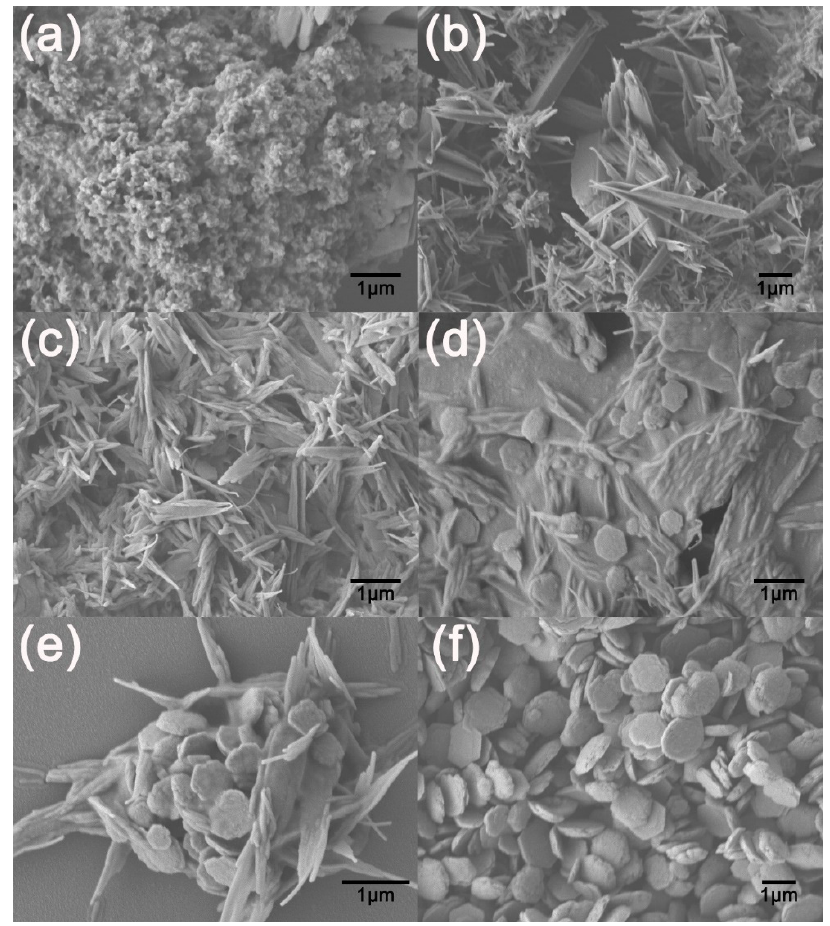
Figure 3. SEM images of products obtained in OS route at different times: ( a ) 0 min; ( b ) 10 min; ( c ) 20 min; ( d ) 30 min; ( e ) 50 min; and ( f ) 70 min.